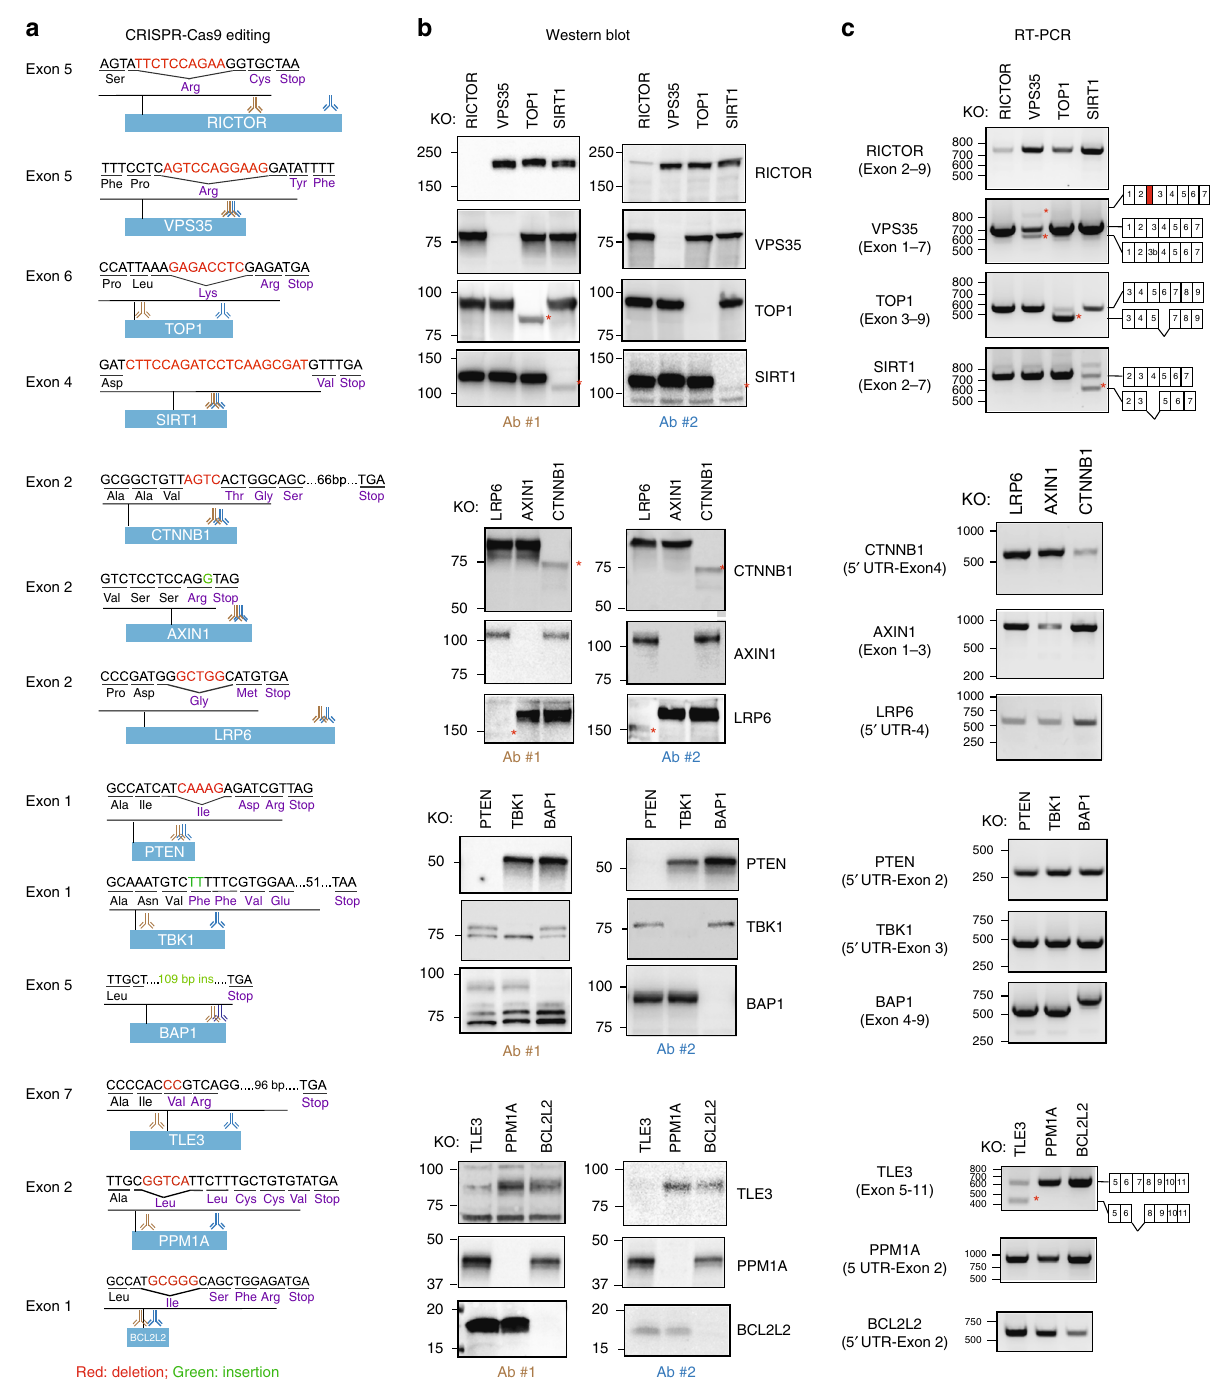
Fig. 1 Unanticipated gene expression outcomes following on-target CRISPR editing. a The effect of CRISPR-introduced frameshift alterations on mRNA and protein expression was analyzed using a panel of CRISPR-Cas9-edited HAP1 cells that were commercially accessible. The targeted exon, anticipated PTC location following insertion/deletion mutation and the protein recognition sites of antibodies used in panel b are indicated. b Appearance of novel proteins in cells edited with CRISPR-Cas9. HAP1 cells were subjected to western blot analysis using two distinct antibodies. Asterisks (*) indicate novel proteins. c CRISPR-Cas9 gene editing induces expression of novel mRNA species. RT-PCR analysis of edited cells was performed using primers recognizing